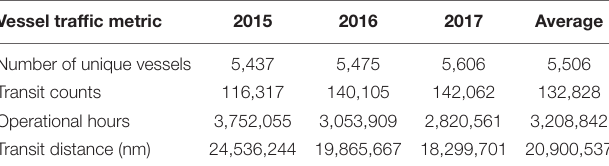
TABLE 1 | Annual Arctic-wide vessel traffic metrics, 2015–2017.